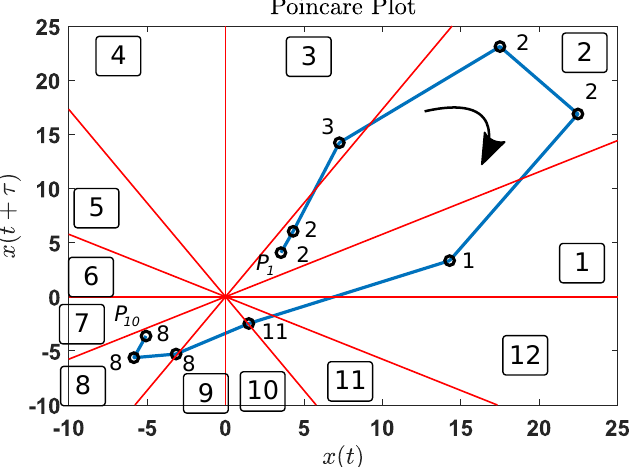
Figure 5. Poincaré plot showing a fragment of component x ( t ) of Lorenz model including the set of symbols